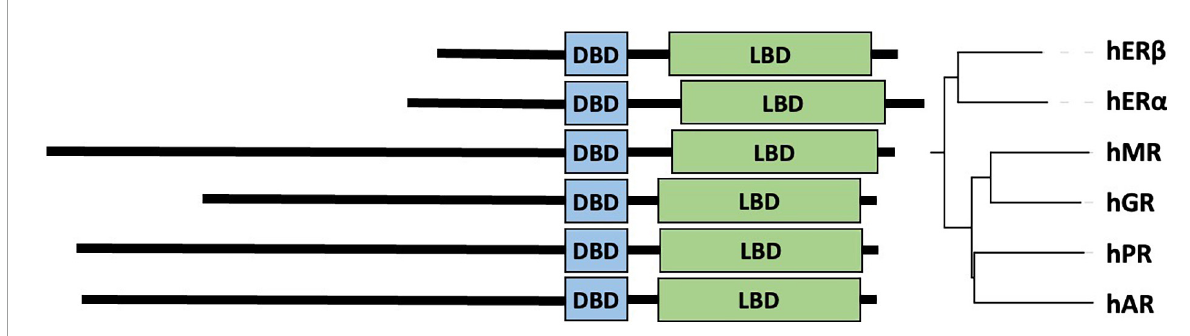
FIGURE1 Similarity of type-1 nuclear hormone receptors. Domain architecture aligned by DBD (left) and neighbor-joining phylogenetic tree (right) of six steroid hormone receptor proteins globally aligned (32). UniProt accessions of the sequences (33) are human estrogen receptor beta (hER β ): Q92731, human estrogen receptor alpha (hER α ): P03372, human mineralocorticoid receptor (hMR): P08235, human glucocorticoid receptor (hGR): P04150, human progesterone receptor (hPR): P06401, and human androgen receptor (hAR):